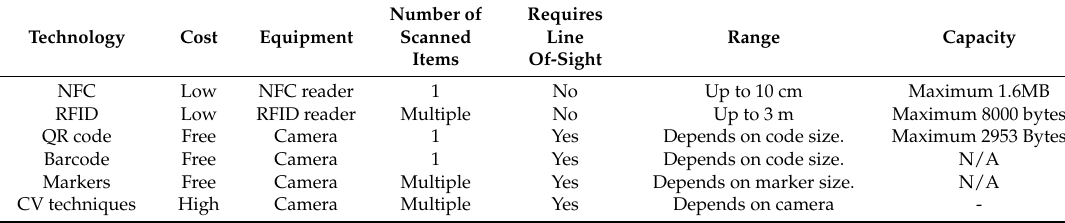
A3: Table 2 summarizes the criteria for the most effective solutions. Table 2. Comparison of identification technologies for